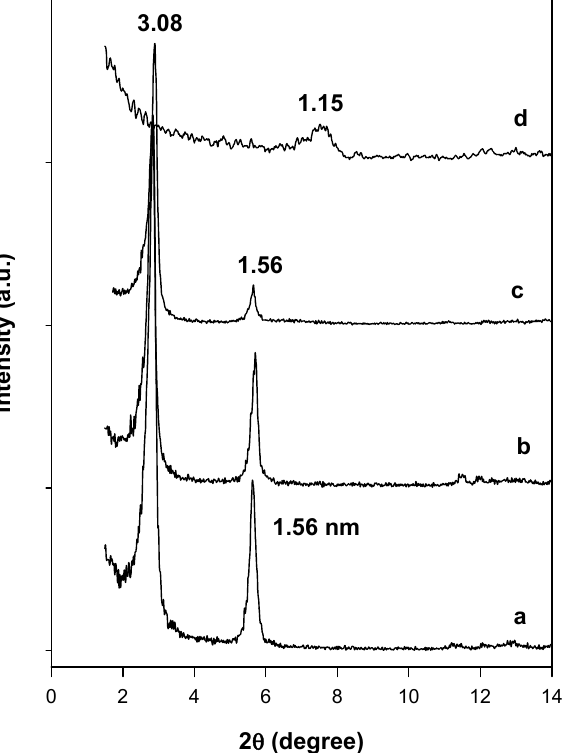
Figure 4. Powder XRD patterns of ( a ) C16Mag-80 treated with different solutions: ( b ) NaOH, ( c ) NaCl, and ( d ) HCl solutions.